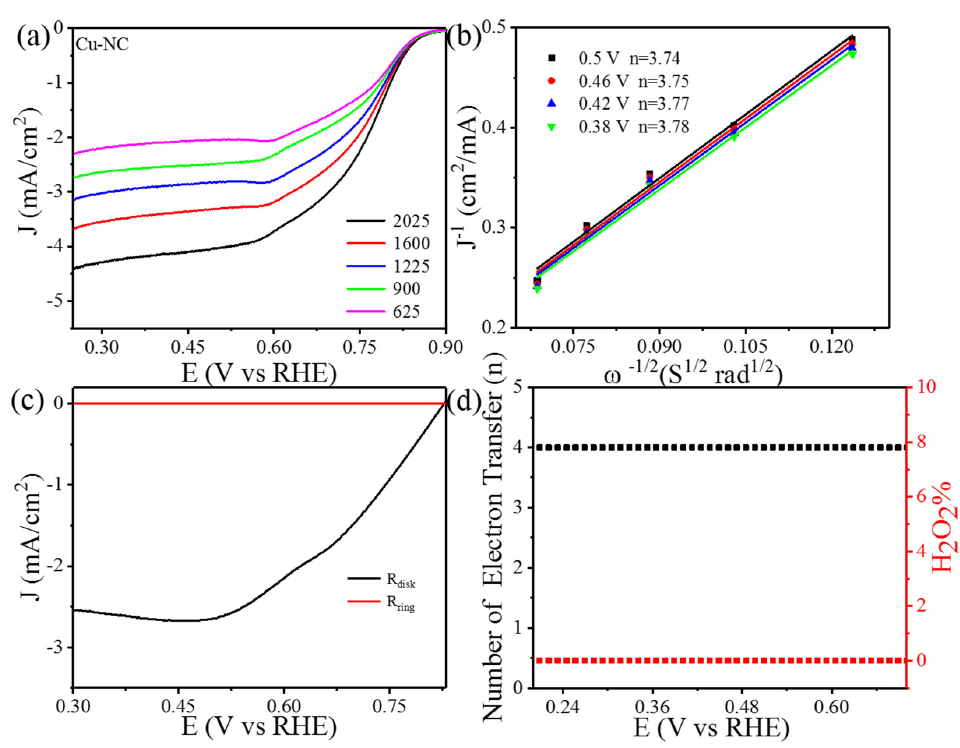
Figure 8. RDE tests ( a ) and corresponding K-L lines ( b ) of Cu-NC in oxygen saturated 0.1 M KOH at various rotation speeds with the sweeping rate of 0.005 V s − 1 . RRDE test ( c ) and the corresponding electron transfer numbers ( n ) and H 2 O 2 % ( d ) of Cu-NC at 1600 rpm with the same sweeping rate.